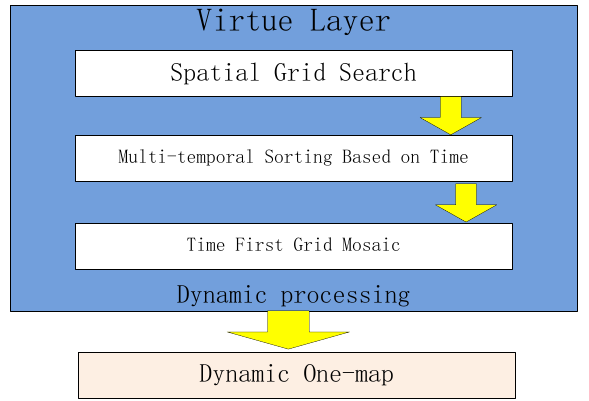
Figure 7. The solution for dynamic one-map service